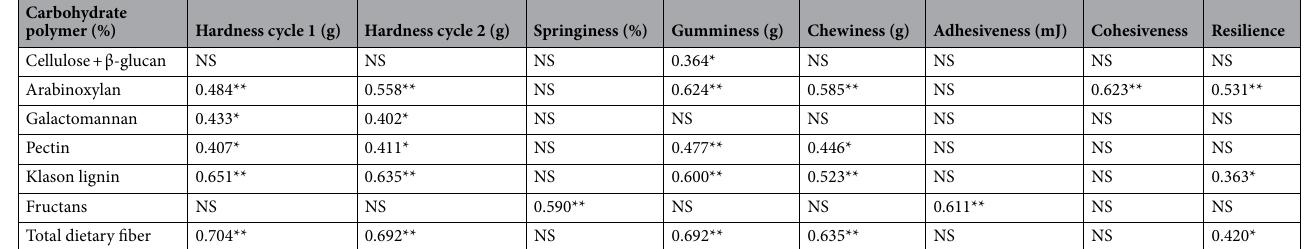
Table 2. Pearson correlation coefficients (r) for the correlations between total fiber and fiber components and the textural parameters of the ten date fruit varieties studied. The correlations are significant at **p-value < 0.01, *p-value < 0.05, and NS